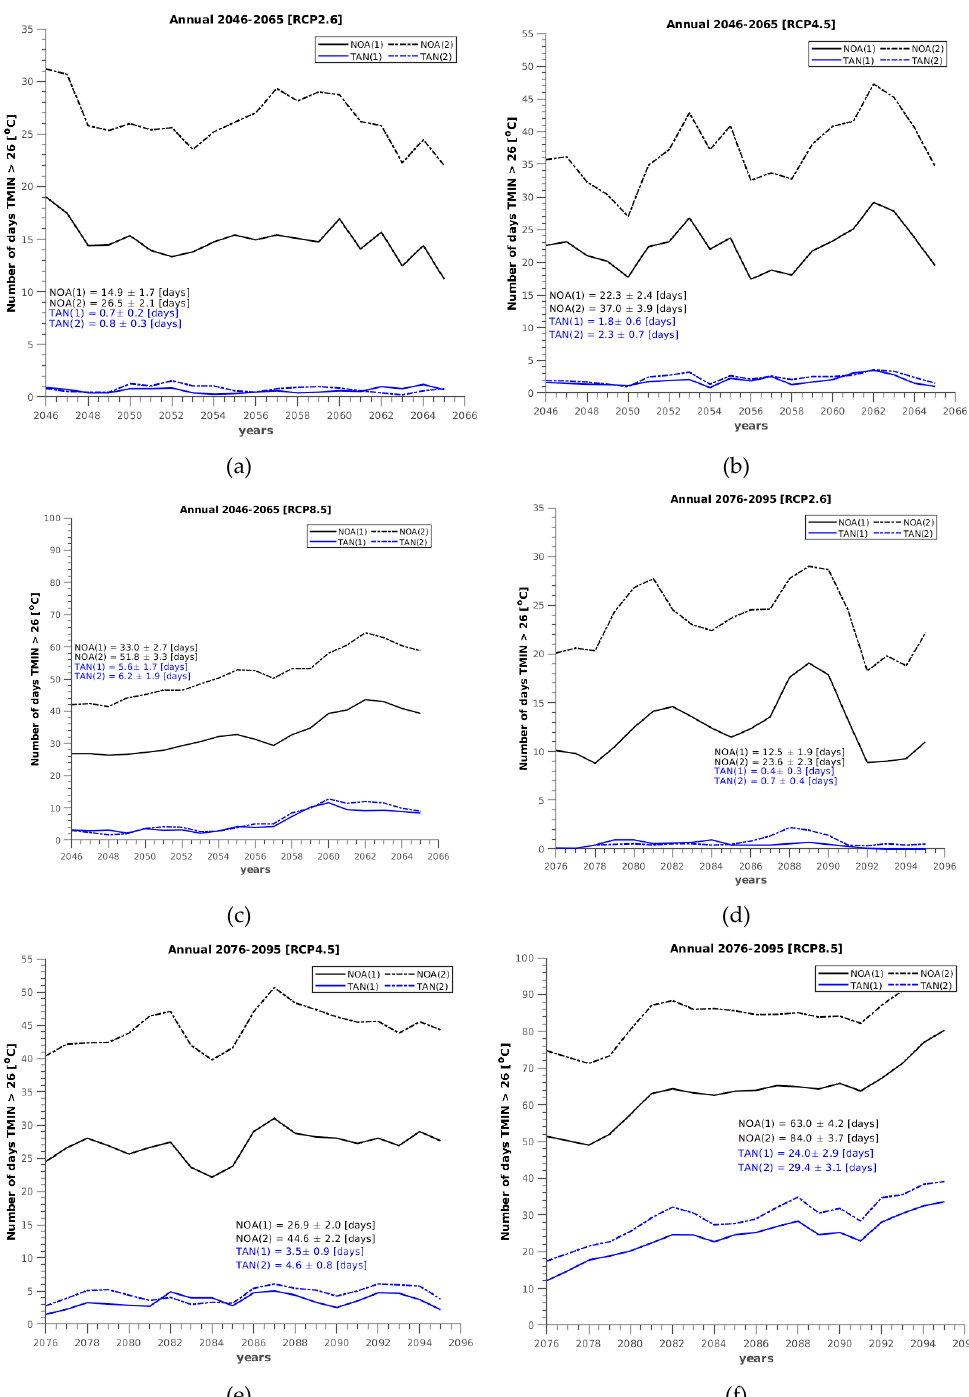
Figure 9. ( a – f ): Annual frequency of extremely hot nights (T min > 26 °C) for the near and distant future periods (2046–2065 and 2076–2095) under climate scenarios RCP2.6, RCP4.5, and RCP8.5. For each period and scenario, simulations NOA (1)/TAN (1) are calibrated against the first reference period (1976–1995) under UHI regime UHI_1 and simulations NOA (2)/TAN (2) are calibrated against the second reference period (1996–2015) under UHI regime UHI_2. Averaged mean change in the frequency with respective confidence interval is given in the figures for each projection.